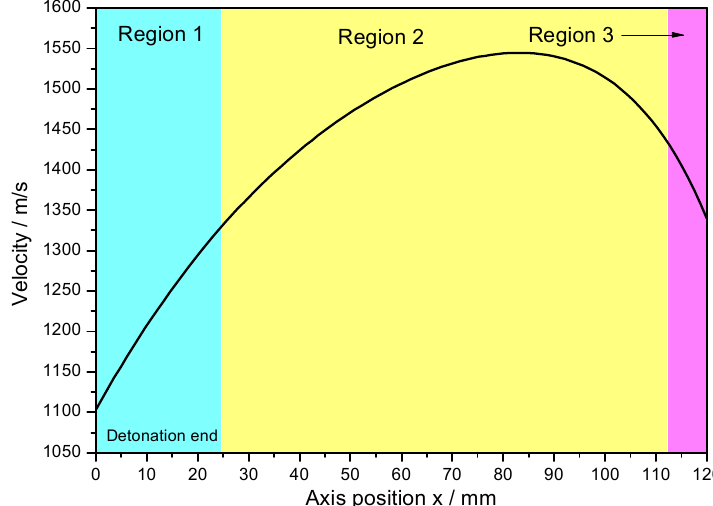
Figure 5. Fragment velocity axial distribution.